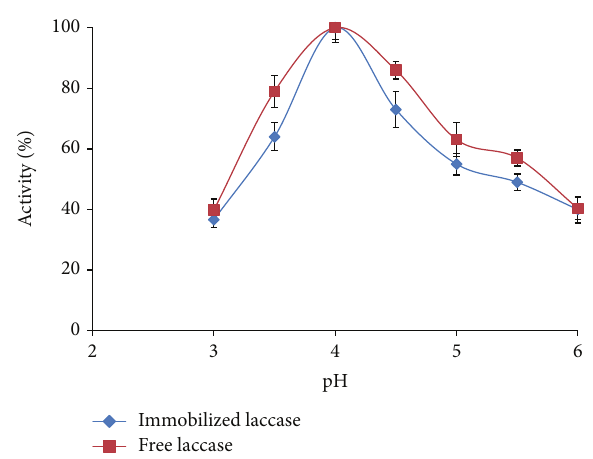
Figure 5: Effect of pH on the activity of free and immobilized form of laccase.